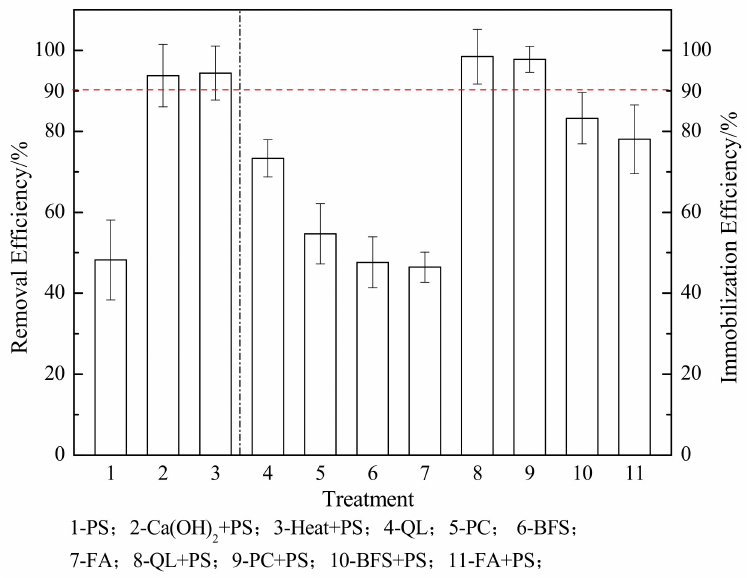
Figure 3. Effect of different treatments on aniline removal and immobilization efficiency in soil co-contaminated with aniline and Cd. Persulfate (PS), Quick lime (QL), Portland cement (PC), blast-furnace slag (BFS), and fly ash